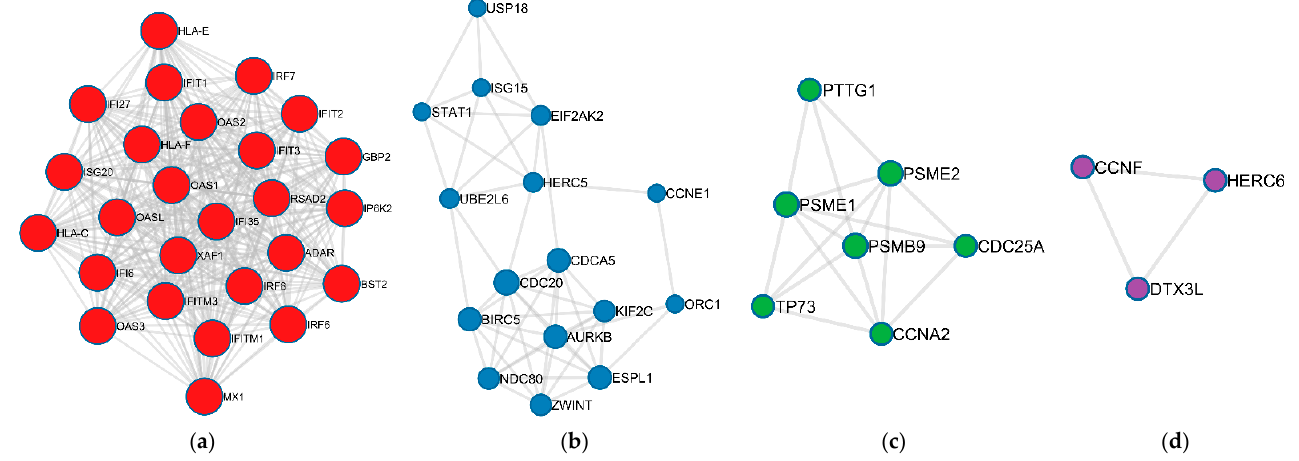
Figure 5. Module detection from the IPIN using MCODE algorithm in Metascape [84]. Circles represent protein nodes. Nodes in each subgraph are colored differently for different modules. The size of nodes represents their connectivity in the modules. ( a ) MCODE1 had 26 nodes (marked as red nodes) and 320 edges. ( b ) MCODE2 had 16 nodes (marked as blue nodes) and 49 edges. ( c ) MCODE3 had 7 nodes (marked as green nodes) and 17 edges. ( d ) MCODE4 had 3 nodes (marked as purple nodes) and 3 edges. Table 2. Clustering of functional enrichment analysis in the IPIN by Molecular Complex Detection (MCODE) algorithm.